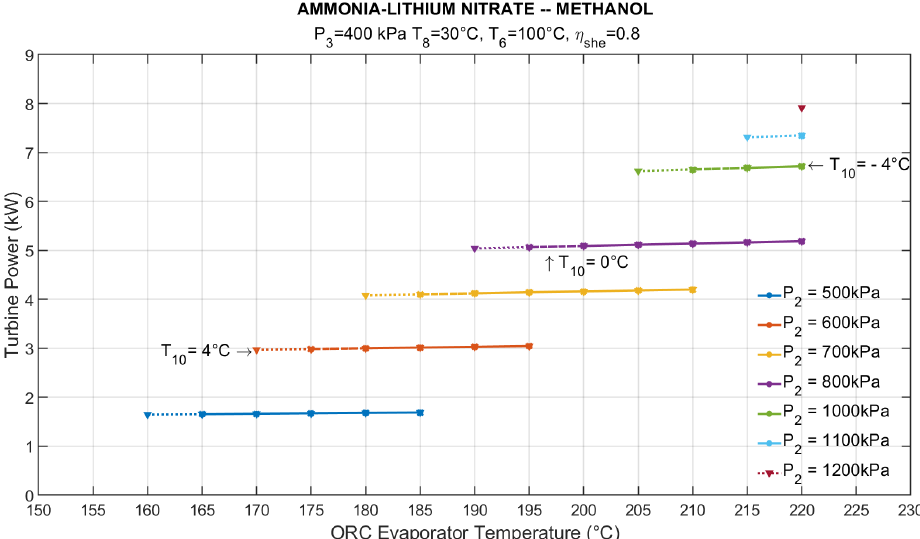
Figure 12. NH 3 -LiNO 3 --CH 3 OH turbine power as a function of heat source temperature and cooling temperature at di ff erent operating conditions.